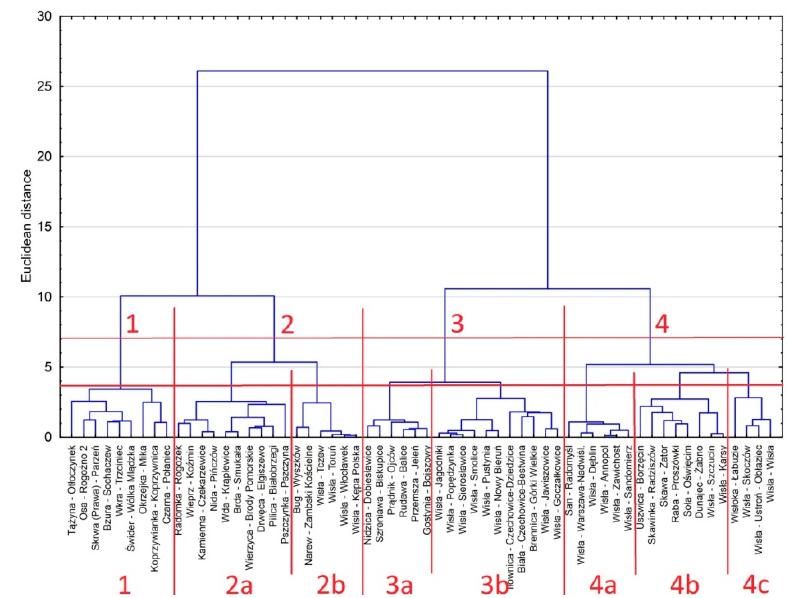
Figure 4. Dendrogram of the Ward’s hierarchical grouping of hydrometric profiles on the Vistula River and its tributaries based on the values of pentadic Pardé’s coefficient (PPC).